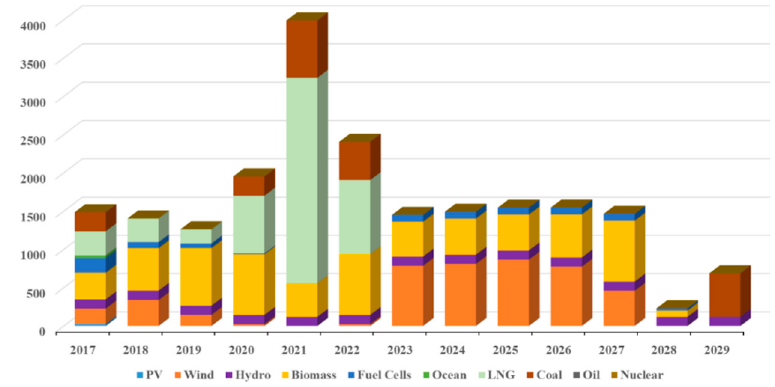
Figure 5. Newly installed capacity of each energy source in SC1.